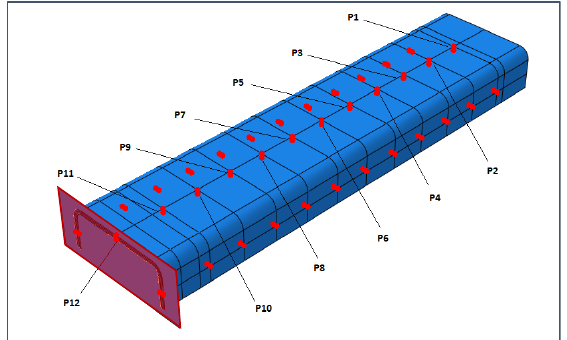
Figure 11. Explicit analysis: Rigid plate and control points.